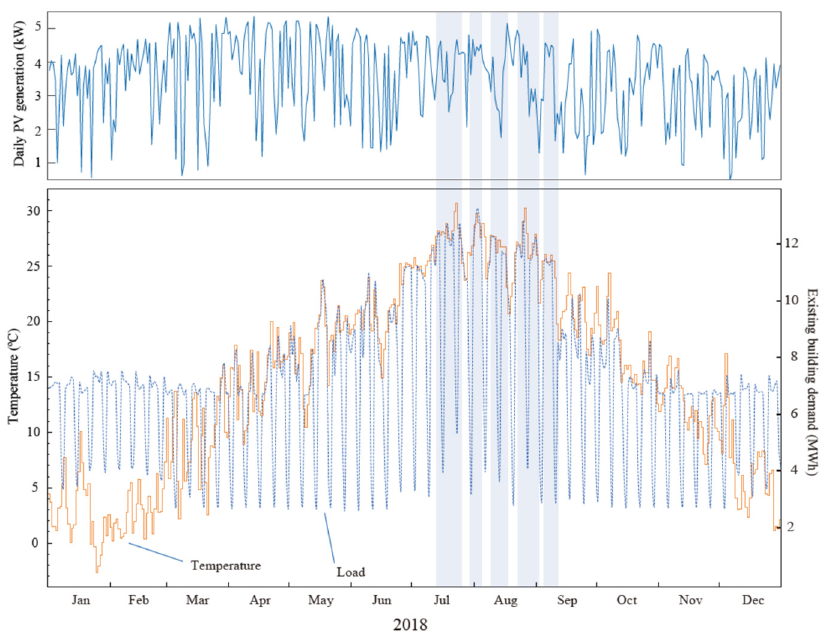
Figure 3. PV generation, daily outside temperature, and estimated demands of existing buildings for the test site in Shinagawa for 2018. Blue bands represent hot days with heightened cooling demand.